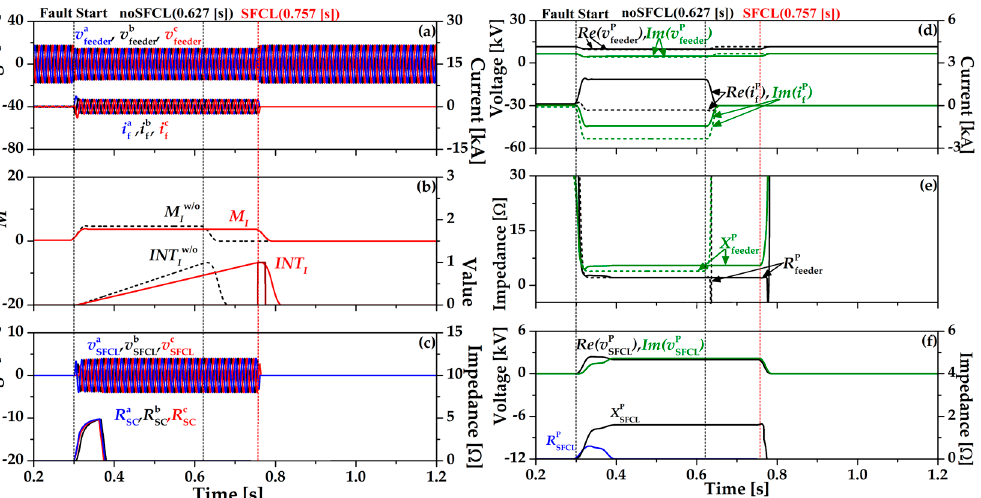
Figure 8. Waveforms and signals of OCR using M I in TLG. ( a ) Three phase feeder voltage ( v feeder ), current ( i f ). ( b ) Index of CB ( M I ) and signal of OCR ( INT I ). ( c ) Three phase SFCL voltage ( v SFCL ), HTSC element ( R aSC , R bSC, R cSC ). ( d ) Positive sequence feeder voltage ( v Pfeeder ), positive sequence feeder current ( i Pf ). ( e ) Sequence feeder impedances ( R Pfeeder , X Pfeeder ). ( f ) Positive sequence SFCL voltage ( v PSFCL ) and positive SFCL impedance ( R PSFCL , X PSFCL ).